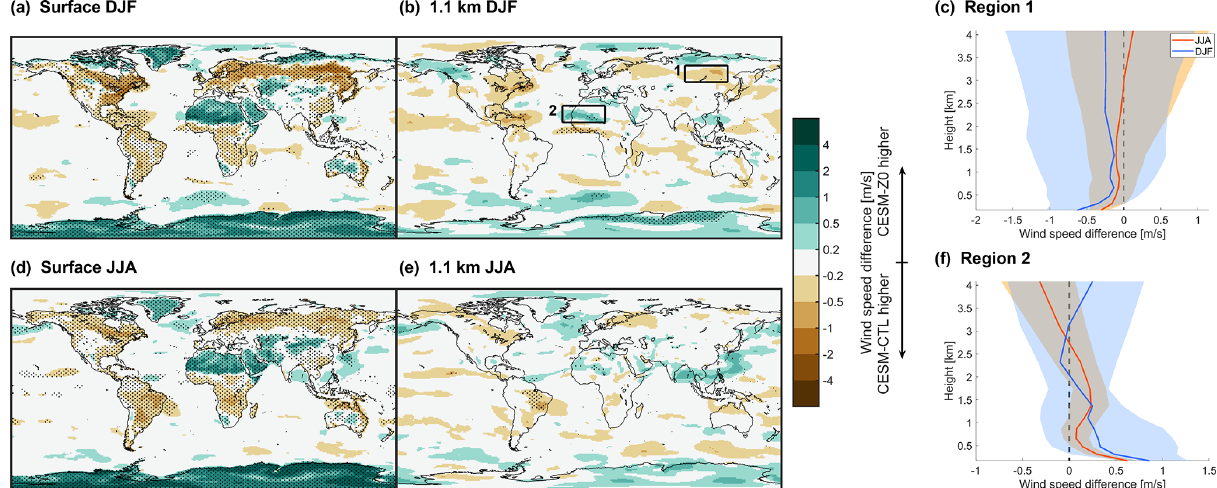
Figure 14. Seasonal mean wind speed difference of CESM-Z0 minus CESM-CTL at lowest atmospheric level (a, d) and approximately 1.1km above sea level (b, e) . Top row shows boreal winter (DJF) and bottom row boreal summer (JJA). The stippling shows areas with a difference that is statistically significant different from 0 in a two-sided t test at the 95% confidence level with a controlled false discovery rate. Note the non-linear color scale. Panels (c) and (f) show the profile of area-weighted mean wind speed difference in DJF (blue) and JJA (red) in regions 1 (c) and 2 (f) , which are marked in panel (b) . The line depicts the median wind speed difference across all seasonal means and shading shows the range between the 10th and 90th percentiles. Height is calculated assuming a surface pressure of 1013.2hPa, a surface air temperature of 288.15K, and a constant lapse rate of 6.5Kkm − 1 . Data from the last 30 years of the spinup period and data from the analysis period (15 years) were used for this